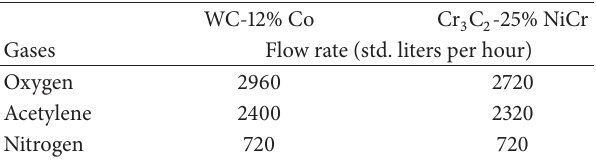
Table 2: Detonation spray